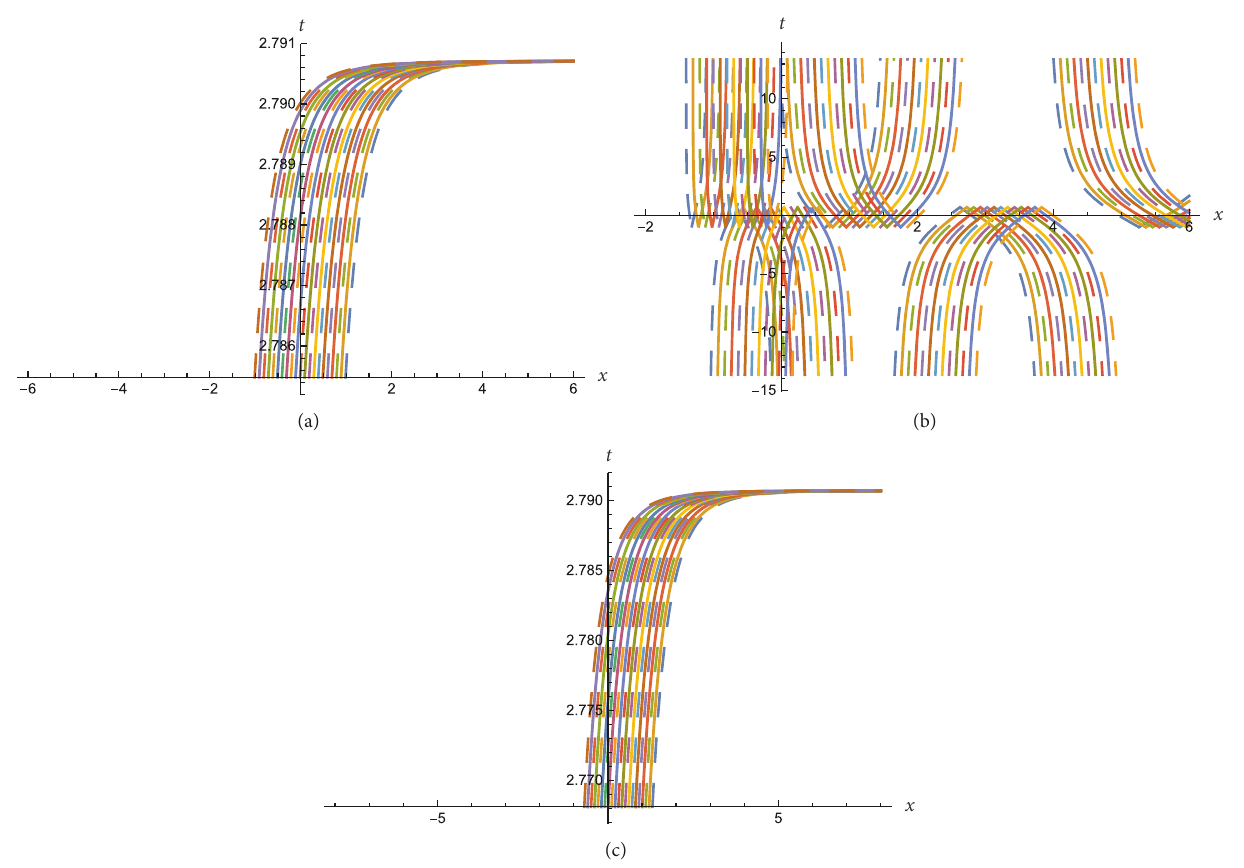
Figure 2: Plot of the exact traveling wave solutions of (a) rational solitary wave solution (17) with parameters 𝑎 1 = 1;𝛼 = 0.6; 𝑙 0 = 0; 𝑙 1 = 9;𝑙 = 20;𝜅 = 0.7;𝑐 = −0.1;𝑦 = 0.8 ; (b) periodic solitary wave solution (19) plotted at 𝑎 2 −0.1; 𝑦 = 0.8 ; and (c) soliton solitary wave solution (21) plotted at 𝑎